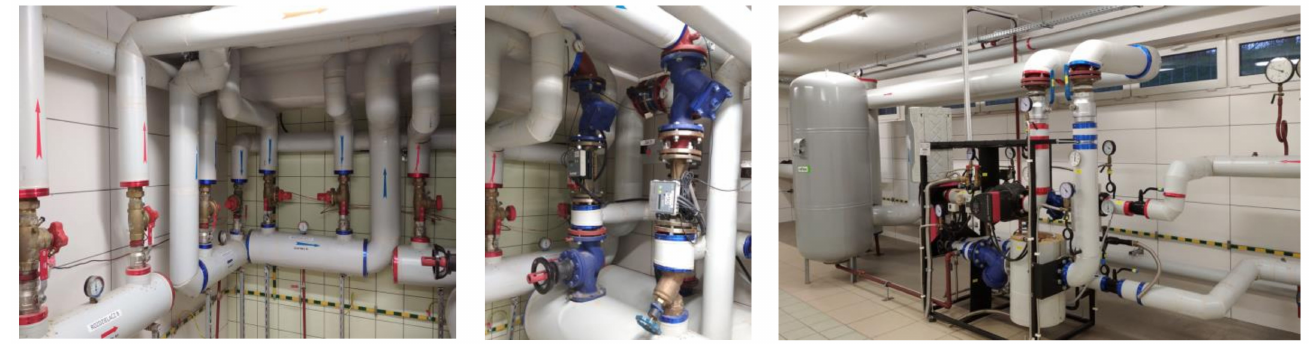
Figure 7. View of the new heat substation and technological devices for building A after moderniza- tion [photo